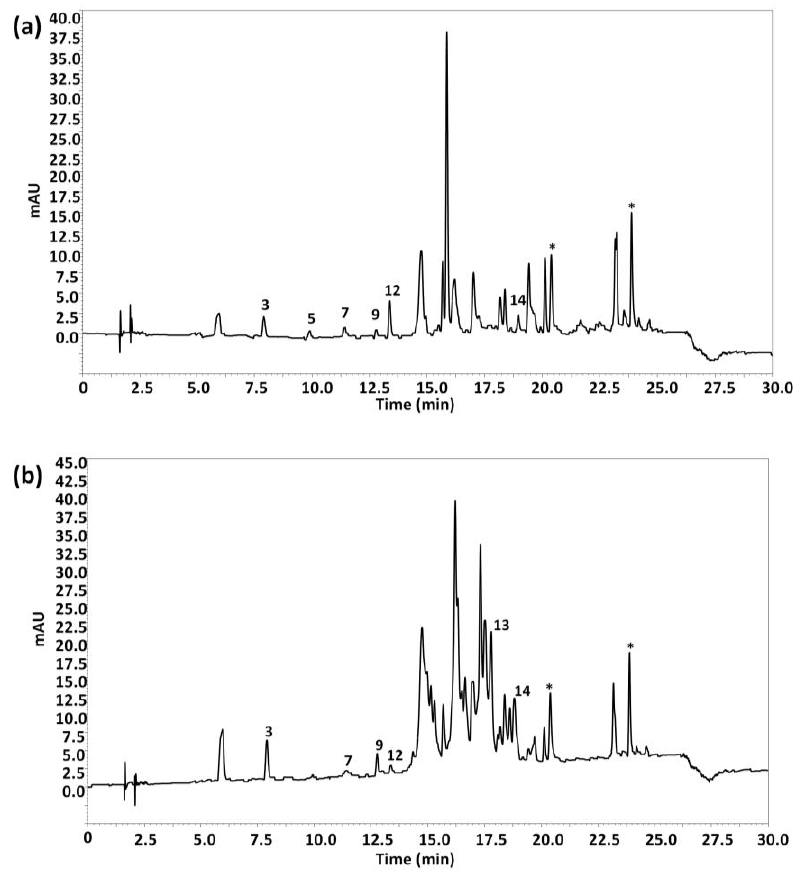
Figure 4. HPLC-UV chromatograms of ( a ) an extra-virgin olive oil (EVOO) obtained from 100% Arbequina olives and ( b ) an EVOO obtained from 100% Picual olives, obtained under optimal conditions. UV detection: λ 280 nm. Peak identification as in Figure 1.